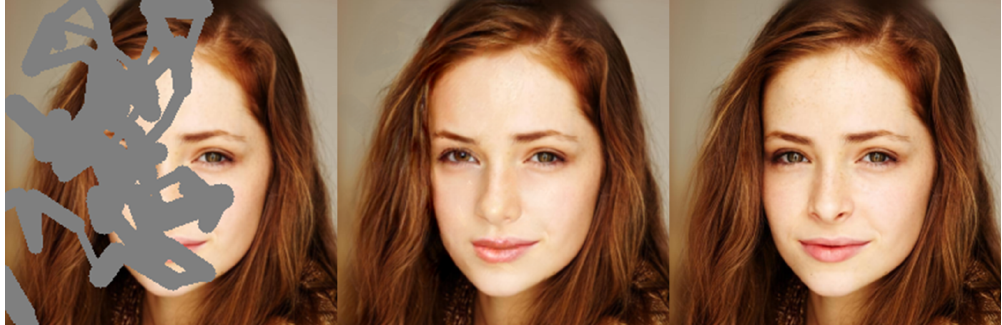
Figure 1. Example of free-form image inpainting. From left, corrupted image with a free-form mask, inpainted image obtained by our proposed method, and respective ground truth. Please note that due to the availability of global and local attention, our model generates visually plausible inpainting